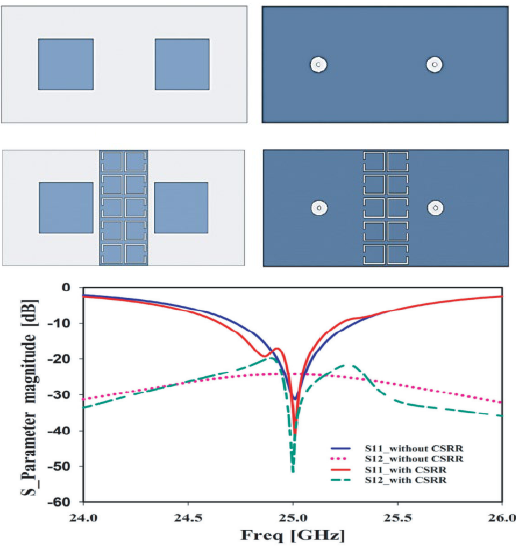
Figure 10. Top and bottom view of antenna with and without decoupling element and the effect of insertion of CSRR to enhance isolation. Reprinted from Ref. [95].